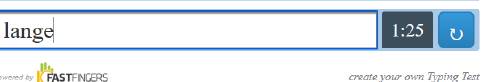
Figure 12. Typing test that was custom-created through the website “10fastfingers.com” [26], with the remaining time shown at the bottom right. Correctly entered words are marked in green and false words are marked in